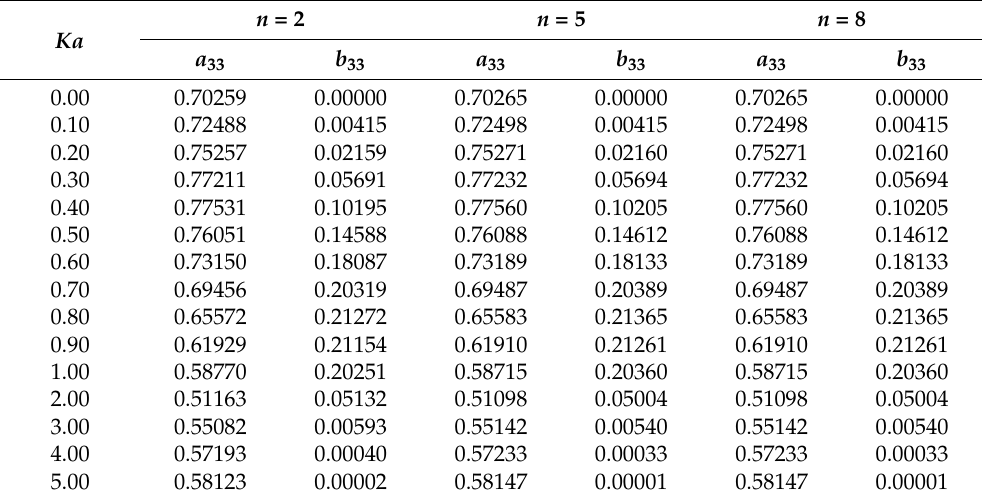
Table 2. Convergence sequence of the normalized heave added mass and damping coefficients for several numbers of modes (oblate spheroid with a / b = 1.25, immersion f = 1.5 a and water depth h = 10 a